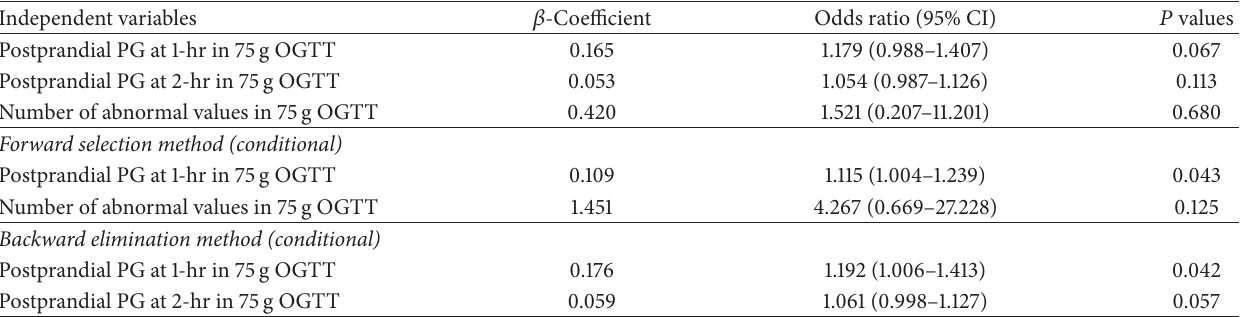
Table 2: Logistic regression analysis after controlling simultaneously for potential confounders of predictors for antenatal insulin treatment (AIT).